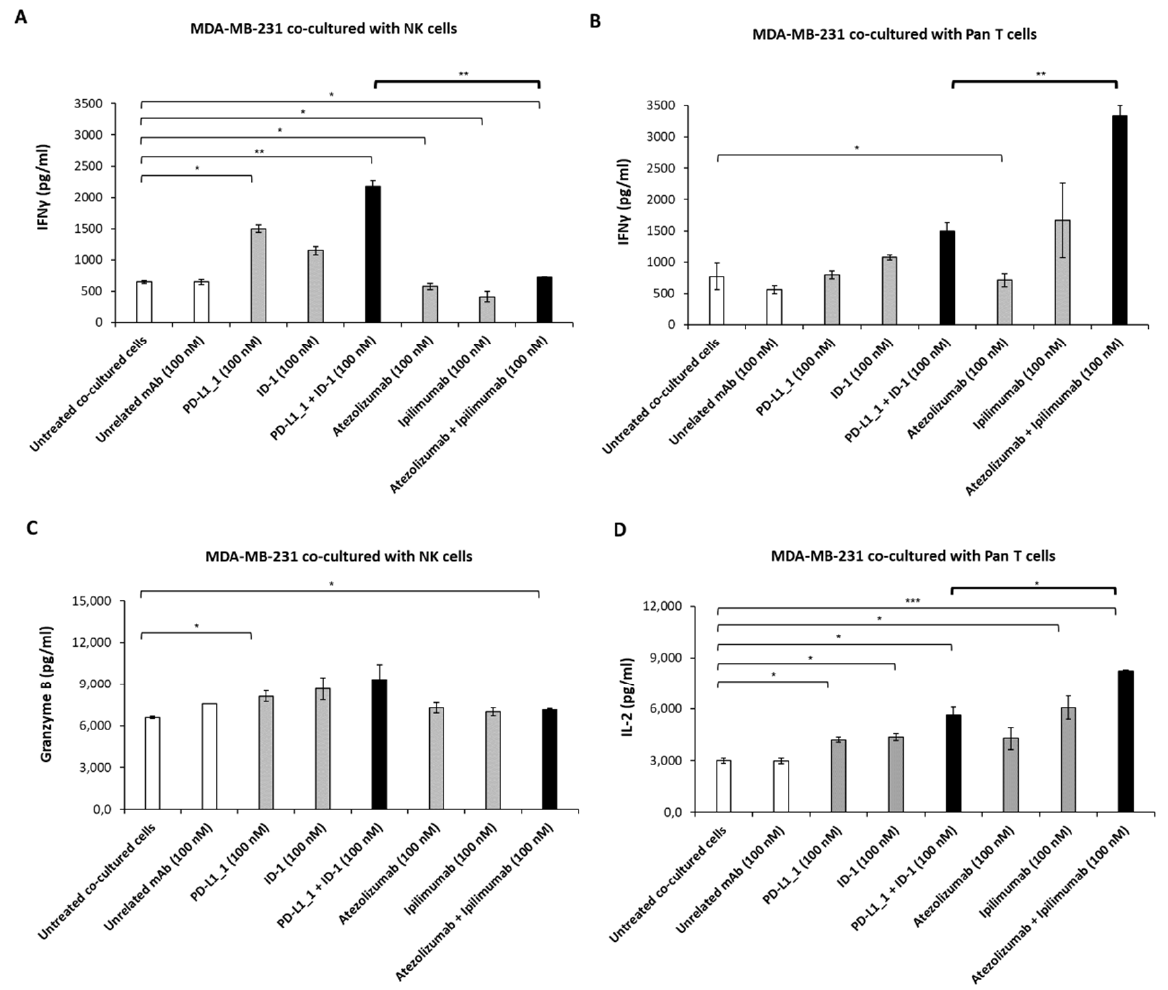
Figure 6. Cytokine secretion induced by the novel mAbs on co-cultures of MDA-MB-231 cells with NK or Pan T subpopulations. Tumor cells were co-cultured with NK ( A ) or Pan T cells ( B ) in the absence or in the presence of anti-CTLA-4, anti-PD-L1 mAbs used alone (grey bars) or in combination (black bars). Untreated hPBMCs or treated with an unrelated IgG were used as negative controls (white bars). The levels of IFN γ ( A , B ), Granzyme B ( C ) and IL-2 ( D ) secreted were measured by ELISA kits, as described above. The values were reported as the mean of at least three determinations obtained in three independent experiments. Error bars depict means ± SD. P-values were calculated by comparing each treatment with untreated co-cultured cells or comparing the two combinations with each other and reported as *** p < 0.001; ** p < 0.01; * p <